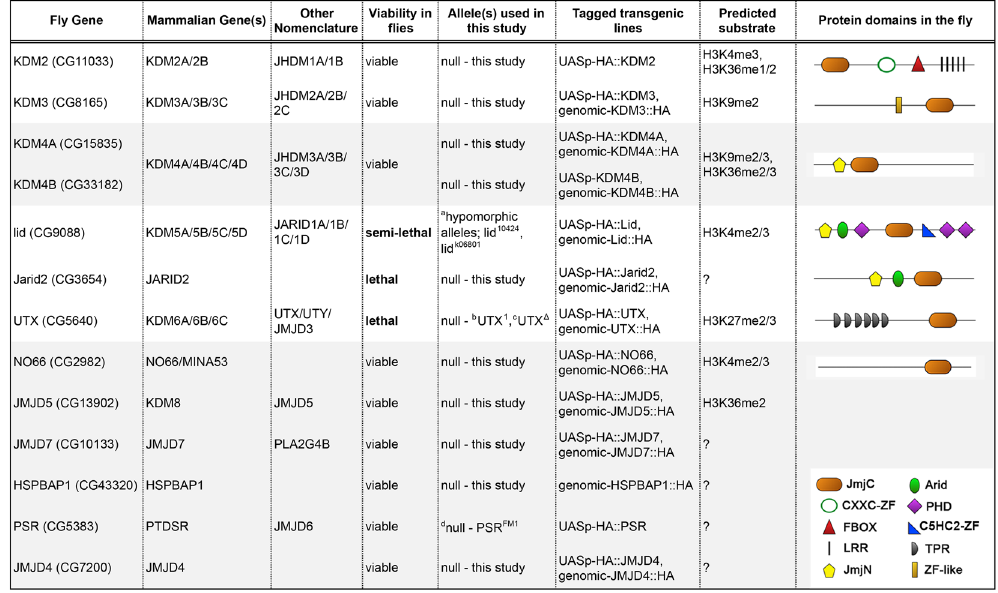
Figure 1. Conservation and tools generated of Drosophila JmjC genes. The first column (Fly Gene) lists all Drosophila JmjC genes, the second (Mammalian Genes) and third (Other Nomenclature) columns are the mammalian homologs (with paralogs) with two nomenclatures listed. The fly and mammalian homologs are grouped and listed based on their phylogenetic relationship determined by protein domain structure and multiple sequence alignments, as presented in (Klose et al ., 2006a). The fourth column (Viability in flies) states the viability of the fly alleles used in this study. The fifth and sixth columns list the alleles used in this study and the transgenic lines generated, respectively. The seventh column (Predicted substrate) states the predicted methyl marks targeted by each JmjC protein and the final column illustrates the selected domains for each Drosophila protein